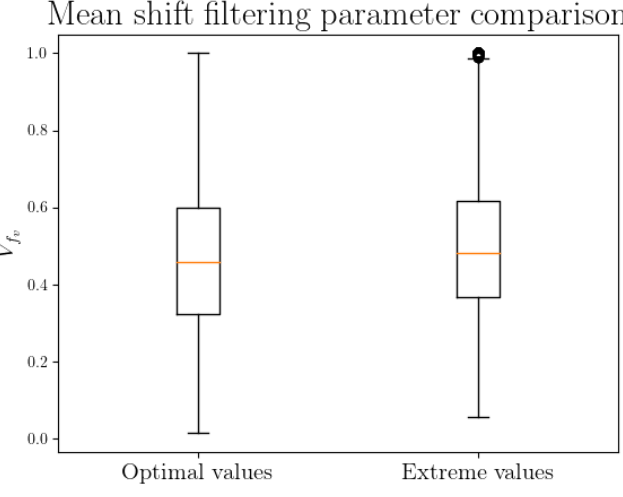
Figure 17. Boxplot showing the V f